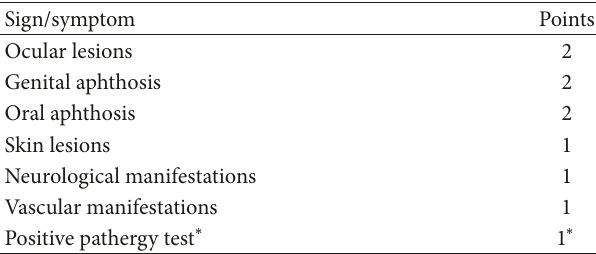
Table 1: International criteria for Behc¸et’s disease, point-score system: scoring ≥ 4 indicates Behc¸et’s diagnosis